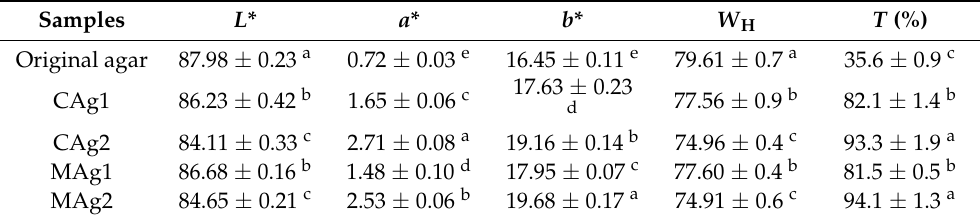
Table 2. Effect of the synthetic method on color and gel transparency of carboxymethyl